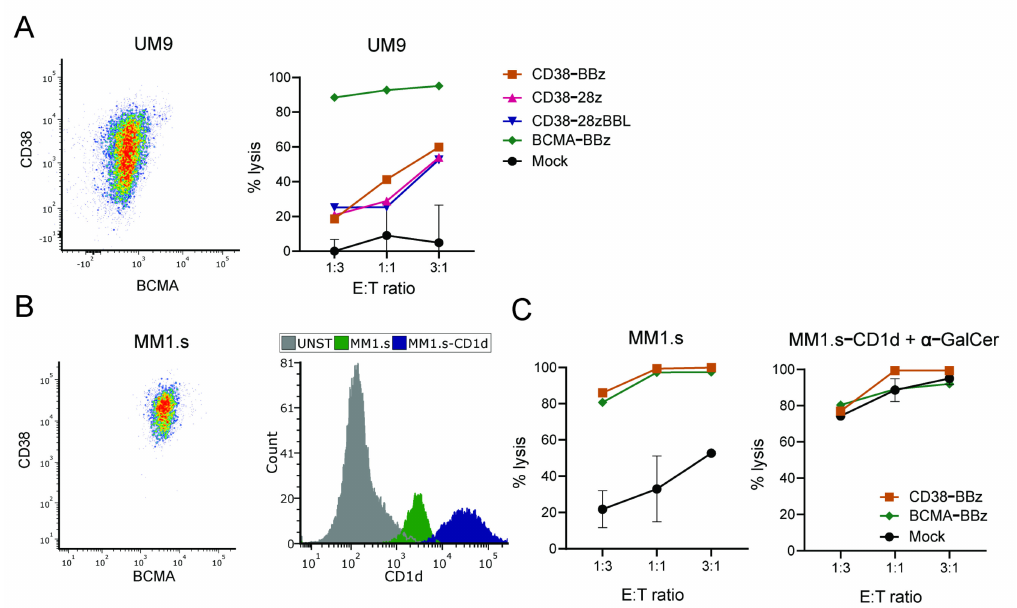
Figure 2. Cytotoxic capacity of iNKT-CARs against multiple myeloma (MM)-cell lines. MM cell lines were co-incubated with CAR iNKT cells at different E/T ratios as indicated for 16 h. ( A ) Flow cytometry density plot of UM9 depicting the expression of CD38 and BCMA and cytotoxicity with CD38-CARs with various co-stimulation domains and BCMA-CAR. ( B ) Flow cytometry density plot of MM1.s depicting the expression of CD38 and BCMA, histogram showing the expression of CD1d on MM1.s and MM1.s-CD1d cell line, and ( C ) cytotoxic activity of BBz-CAR iNKT cells on MM1.s cells after 16 h of co-incubation. Data is representative of 2 independent experiments. Error bars depict the